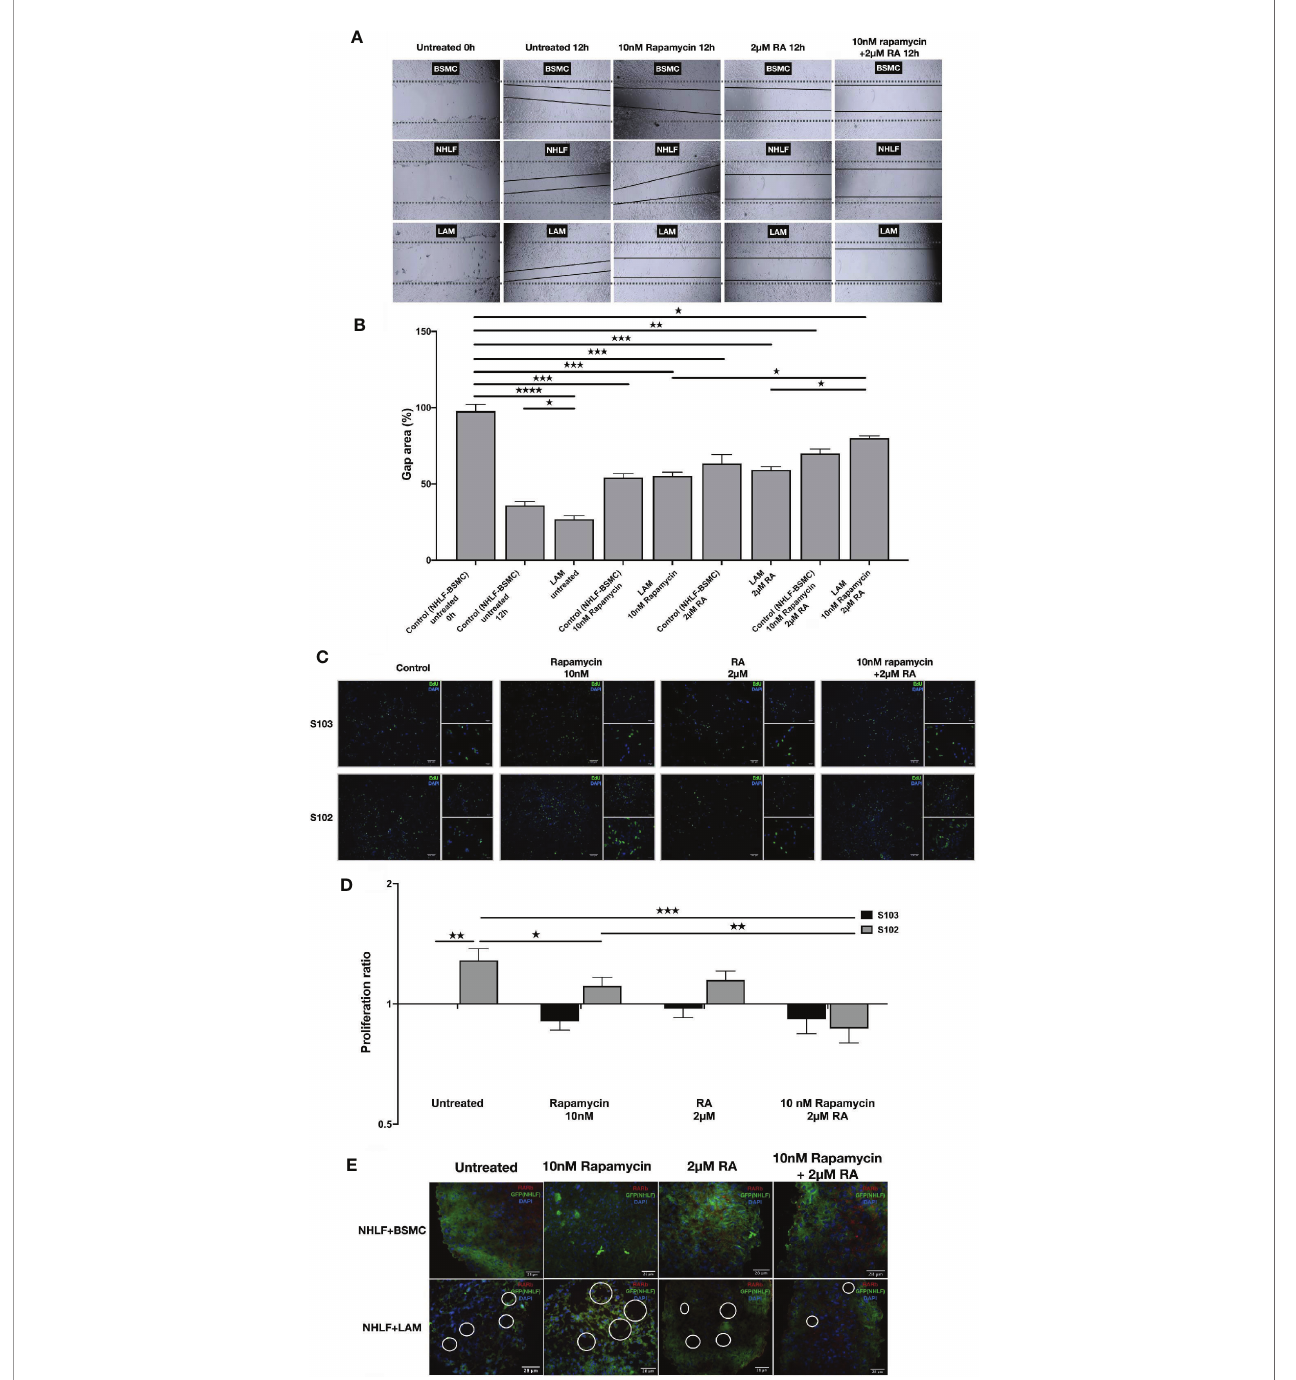
FIGURE 4 | RA mono and RA and rapamycin combination treatment reduces cellular migration and proliferation in TSC-de fi cient cells. (A) Wound healing scratch assay following 10 nM rapamycin and/or 2 µM RA treatment for 24 h. (B) Wound gap area quanti fi cation, data are presented as gap area (%) compared to untreated control (BSMC and NHLF, 1:1) as 100%. Differences in gap closure % ± SEM. Signi fi cant changes are marked as ★ , ★★ , ★★★ and ★★★★ (P<0.05, P<0.001, P<0.0002 and P<0.0001, respectively). (C, D) Proliferation capacity of S102 compared to S103 using BrdU assay (BrdU green, DAPI blue, size-bar 100, 50, 25 m m). Proliferation ratio compared to untreated S103 ± technical error of replicates (t-test). Signi fi cant changes are marked as ★ , ★★ and ★★★ (P<0.05, P<0.001 and P<0.0002 respectively). (E) Empty sac formation in NHLF-LAM co-cultures compared to NHLF-BSMC co-cultures in the presence or absence of 10 nM rapamycin and/or 2 µM RA treatment (24 h). Empty sac formation is marked with white circles in the staining where RAR b is red, NHLF-GFP is green and the nucleus is stained by DAPI